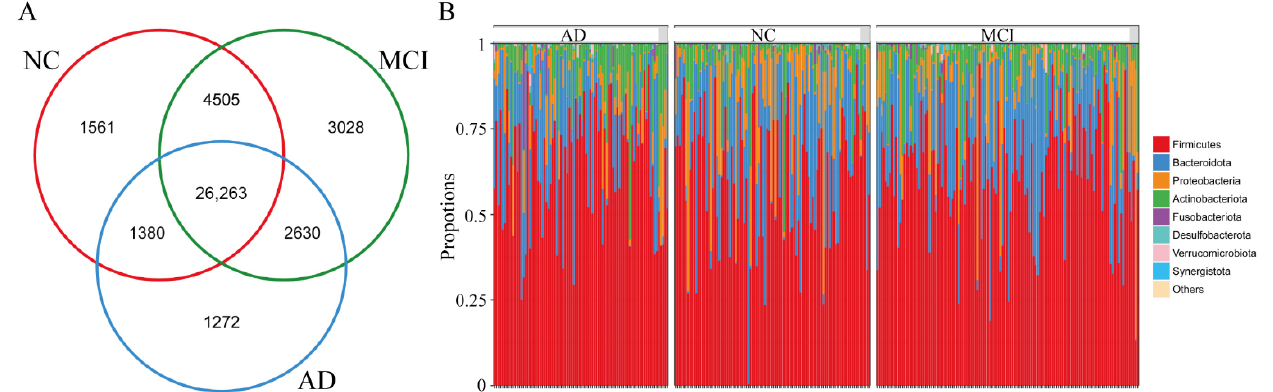
Figure 1. The overall structure of the gut microbiota based on the analysis of microbial diversity among NC, MCI, and AD. ( A ) Venn diagram showing the overlap of the OTUs found in the gut microbiota among NC, MCI, and AD. ( B ) The gut microbial compositions at the phylum levels among NC, MCI, and AD. NC, cognitively normal controls; MCI, mild cognitive impairment; AD, Alzheimer’s disease; OTUs, operational taxonomic units.